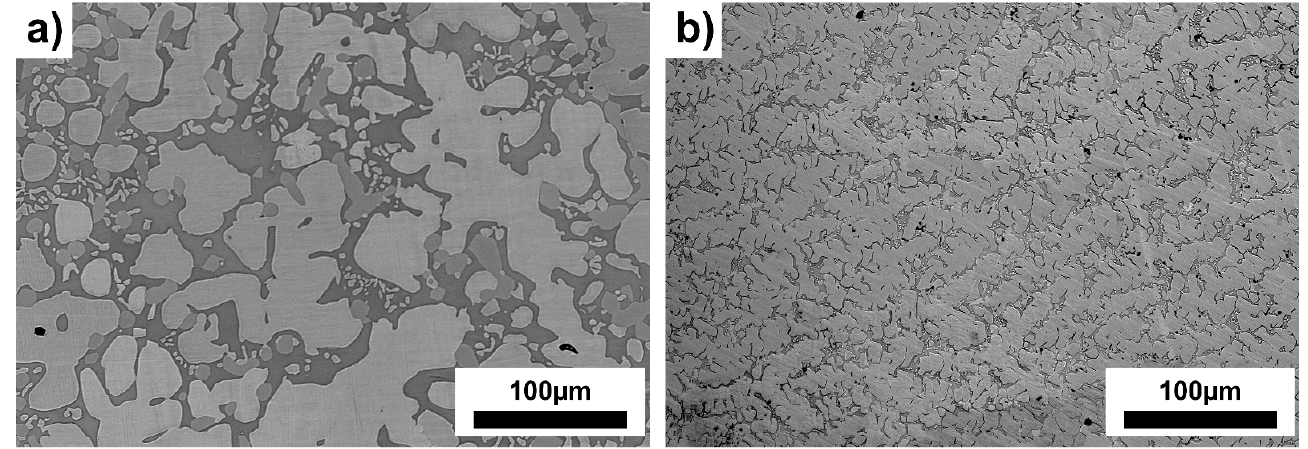
Figure 5. Backscattered electron images of induction-melted ( a ) and arc-melted ( b )